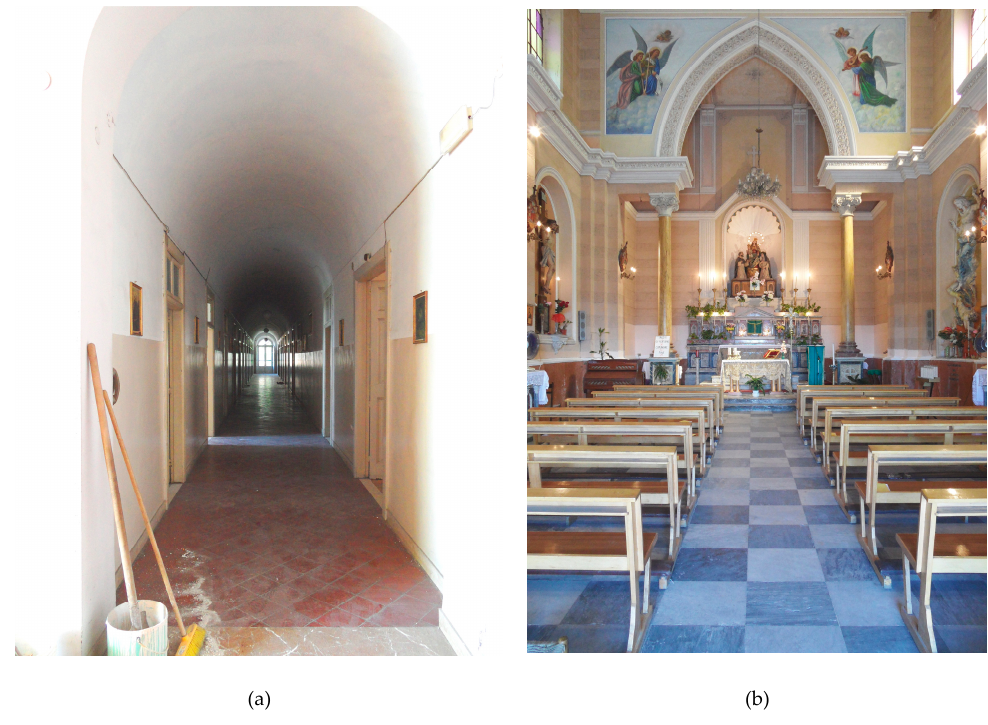
Figure 5. Interiors of the convent ( a ) and the church ( b ).